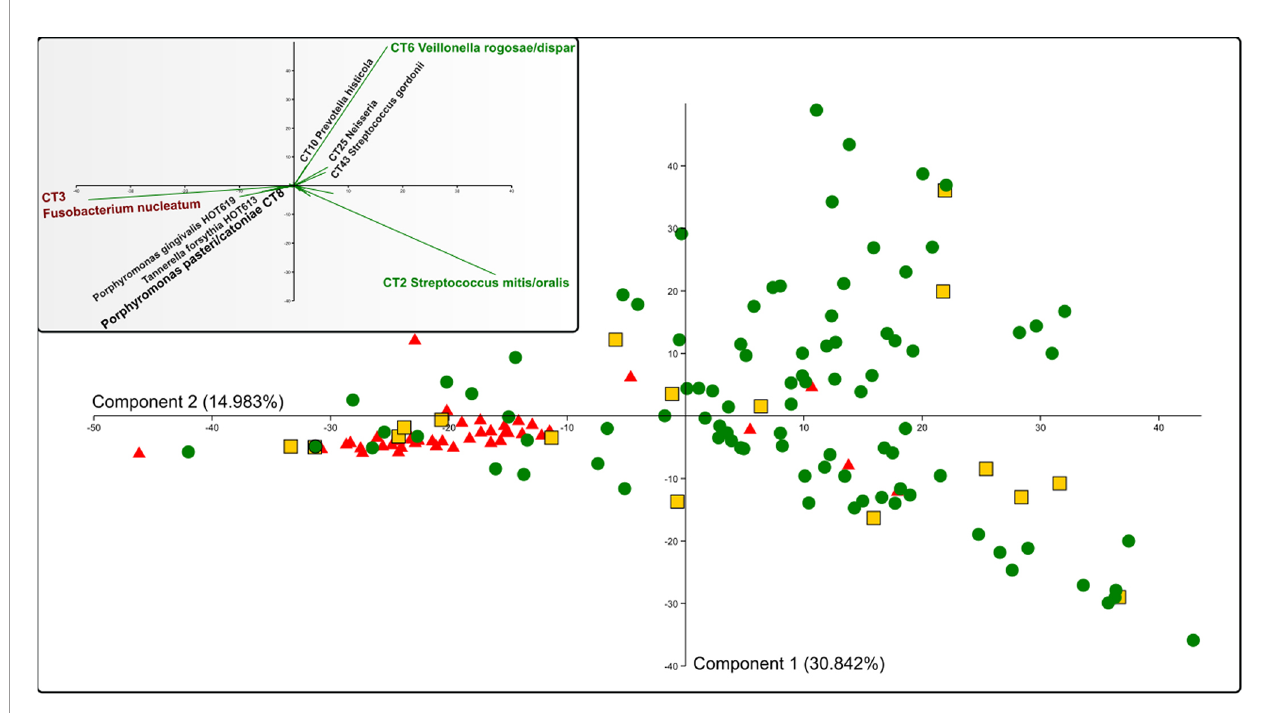
FIGURE 3 | PCA analysis of all OM samples. Red triangles represent AP samples, green spots HY, and yellow squares represent the HO samples. The inner panel shows the contribution of selected oral taxa to the distribution. The determining taxa for each quadrant are highlighted in colors (green for periodontal health and red for periodontitis), CT8 P. pasteri/catoniae determining the transient state is highlighted by a bigger font. CT stands for combined taxon (See Supplementary Table 3